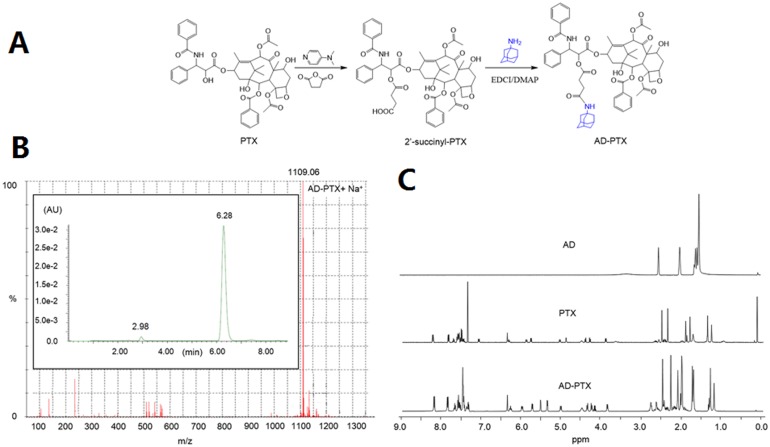
AD-PTX synthesis and characterization.Synthetic route of AD-PTX (A); LC-MS spectra of AD-PTX (B) and 1H-NMR spectra of AD, PTX and AD-PTX in DMSO-d6 (C).